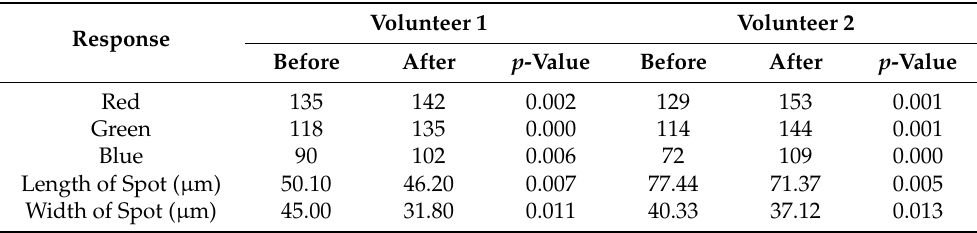
Table 5. RGB value and size of dark spots of volunteers 1 and 2, analyzed by a paired samples t -test